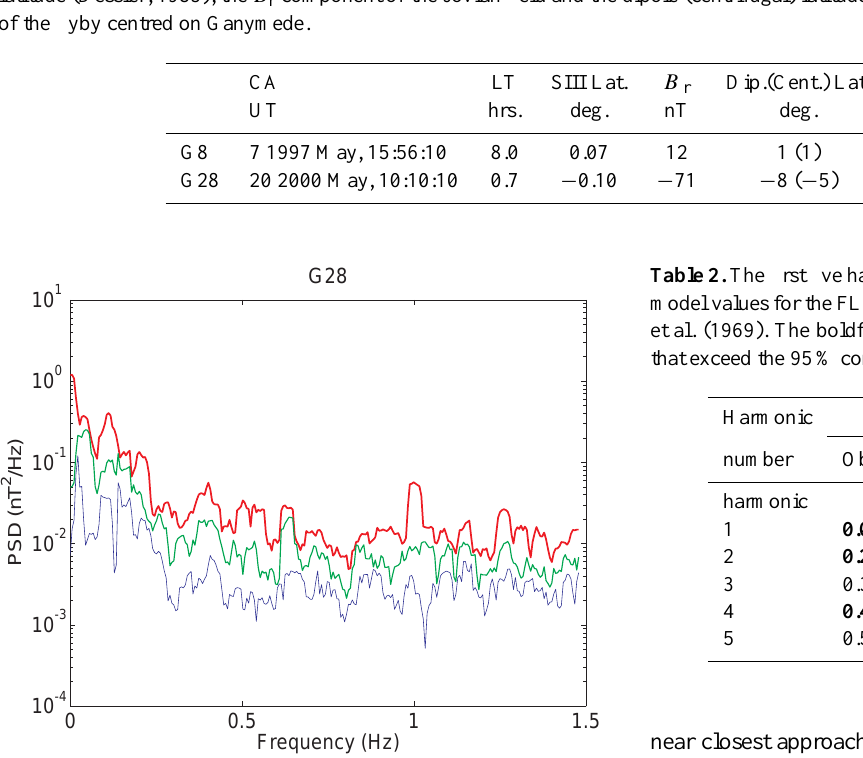
Fig. 2. The spectral density for the G28 flyby during the interval of field line resonances in the eigenvector system obtained from the real part of the cross-spectral matrix (Arthur et al., 1976), with maximum eigenvalue in red, intermediate in green and minimum in blue.